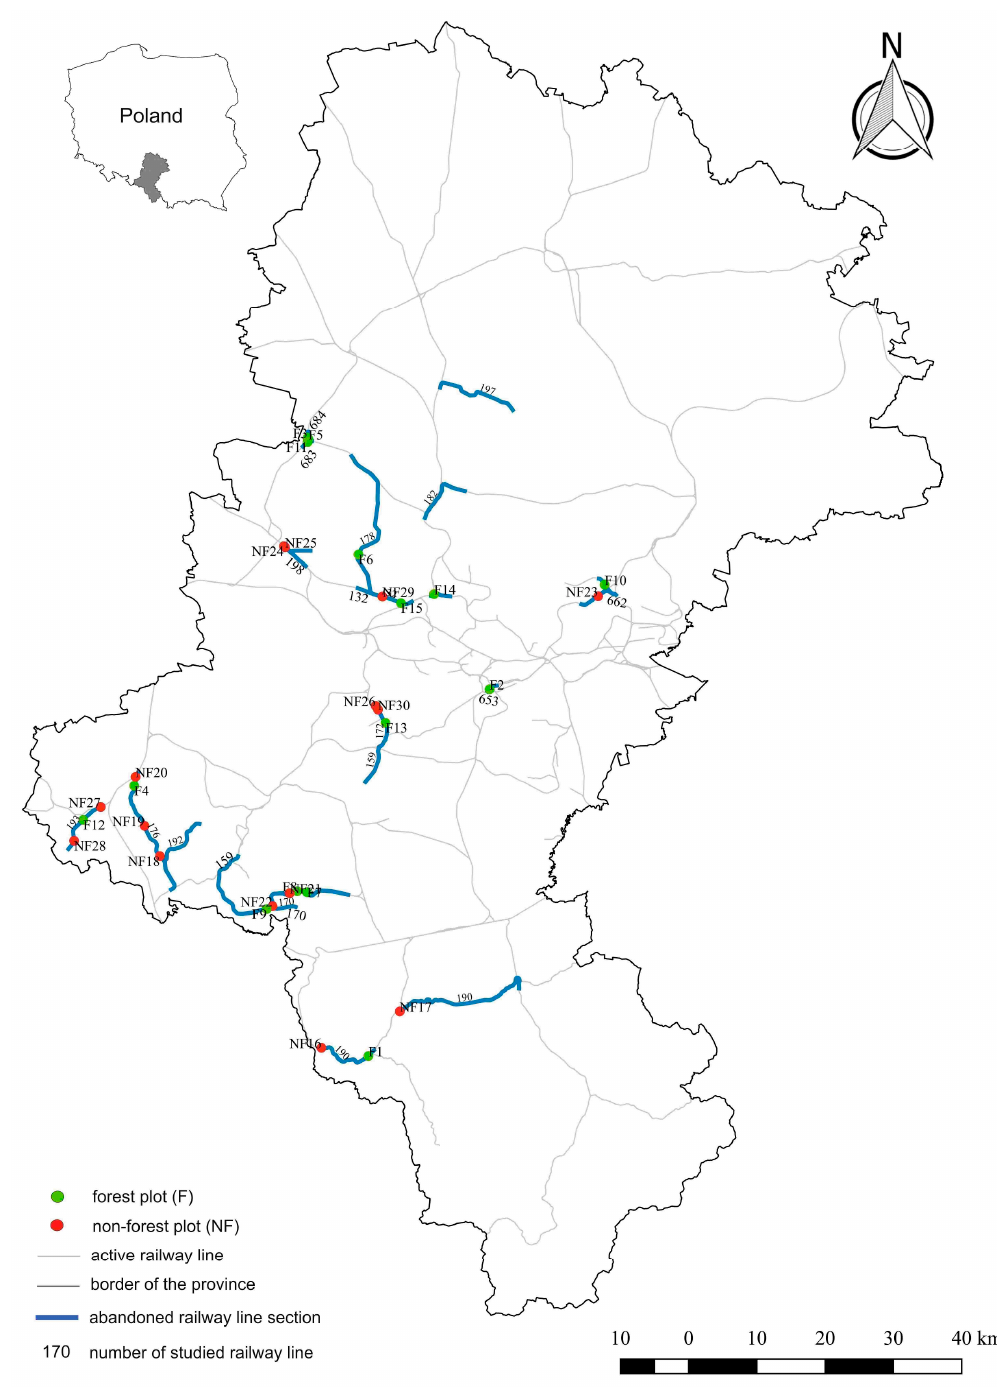
Figure 1. Location of the studied plots against the background of the borders of the Silesia Province. The forest cover of the Silesia Province is 32.1%. Public forests account for 80.5% of the total forest land, while private forests account for 19.5%. The State Treasury owns 79.6% of the forest land, of which 97.8% is managed by the State Forests. The study area is dominated by lowland mixed coniferous and mixed forests. The most common forest- forming species are pine, oak, spruce, and birch [50].